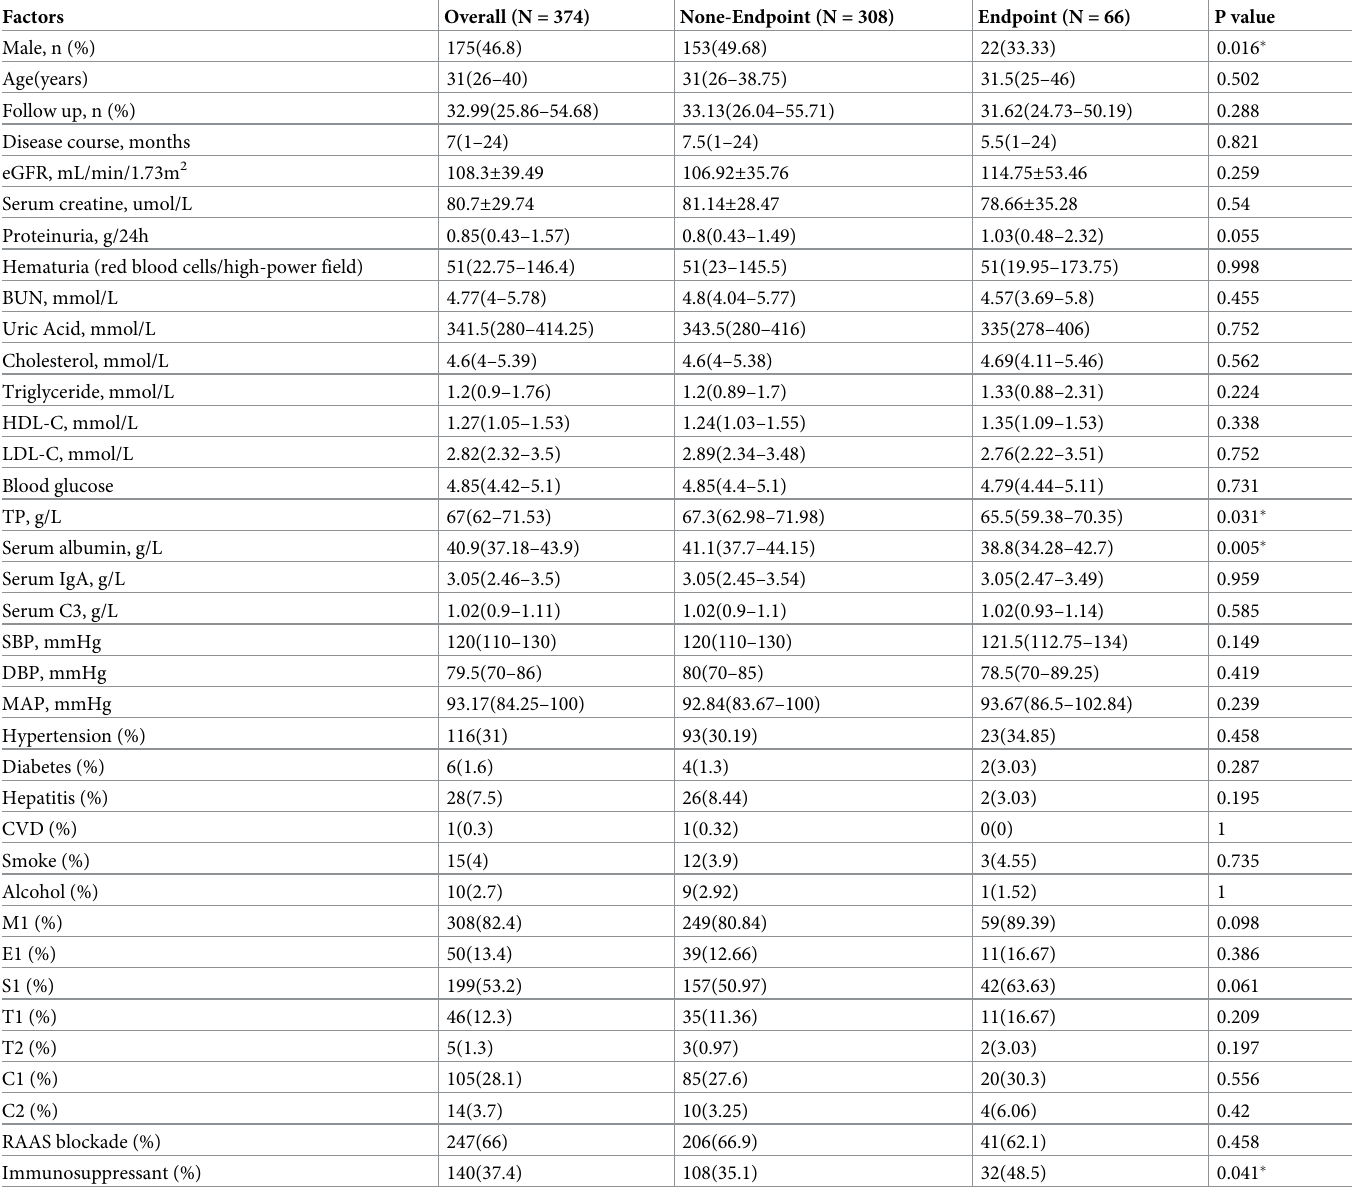
Table 1. Baseline cohort